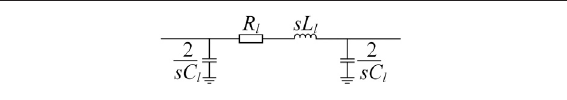
FIGURE 11 | The CDM model of the DC line.